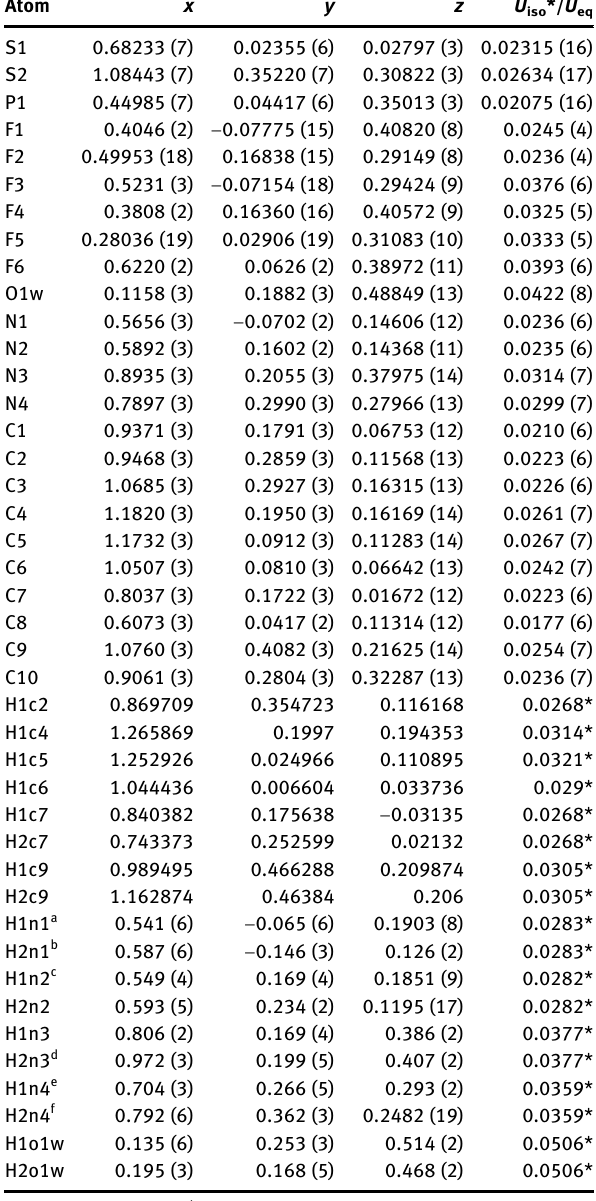
Table  : Fractional atomic coordinates and isotropic or equivalent isotropic displacement parameters (Å 